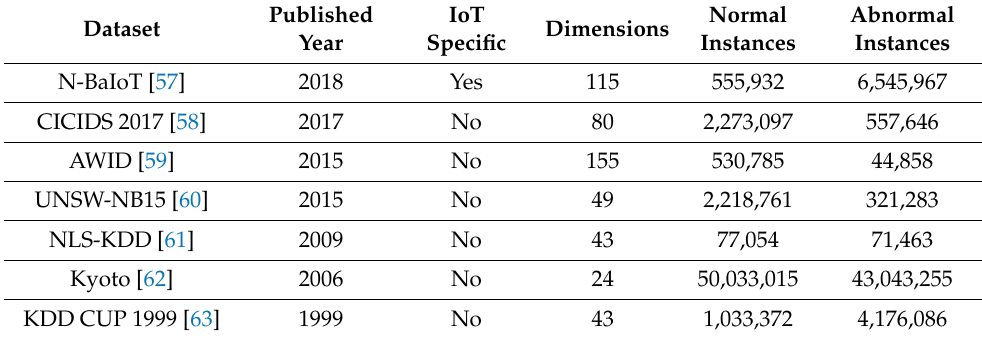
Table 3. Common Datasets for Anomaly Detection in the IoT System (Adapted from [1]).